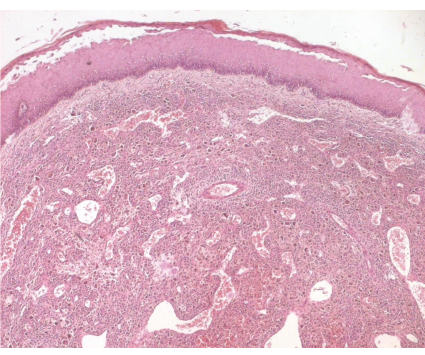
Figure 2: Cellular dermal proliferation of spindle and pleomorphic cells with epidermal hyperplasia, a grenz zone, and prominent blood-filled spaces (hematoxylin and eosin × 40).